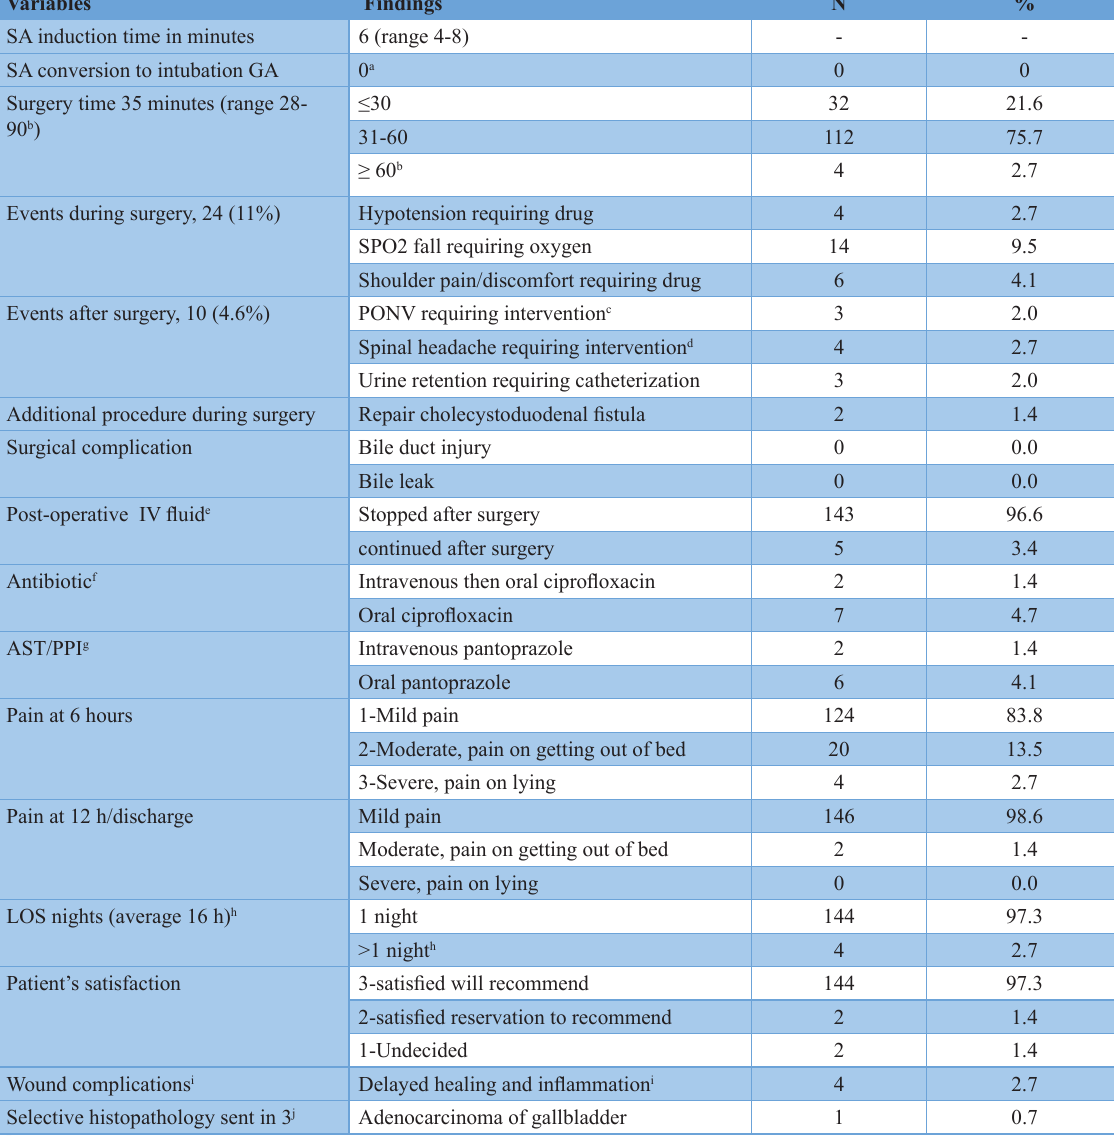
Table 2. Outcome of muscle-splitting mini-incision open cholecystectomy (MC) under spinal anesthesia (SA),N=148 Variables